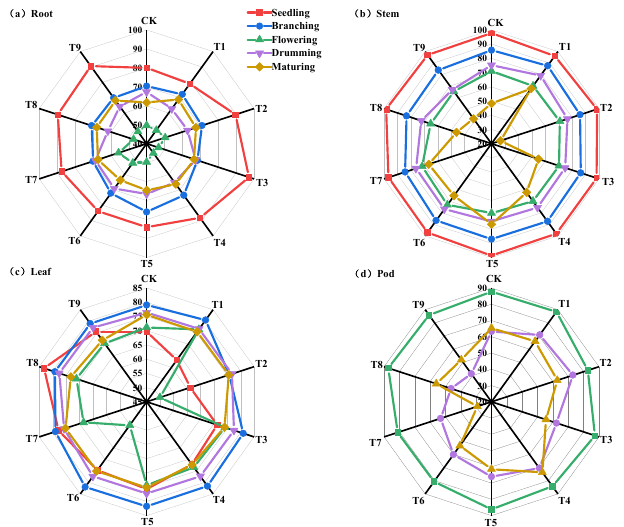
Figure 6. Variation in the wet-basis water content of each organ of the mung bean plant. From the seedling to the branching stage, the wet-basis moisture content of the leaves increased, except in the T8 treatment (Figure 6c). However, from the branching to the flowering stage, all treatments decreased, while the T2 and T6 treatments decreased sig- nificantly, by 34.21% ( p < 0.05) and 32.93% ( p < 0.05), respectively. Across all treatments, the wet-basis moisture content increased from the flowering to the drumming stage, while the T2 and T6 treatments increased significantly, by 49.09% ( p < 0.05) and 40% ( p < 0.05), respectively. However, all treatments decreased from the drumming to the maturing